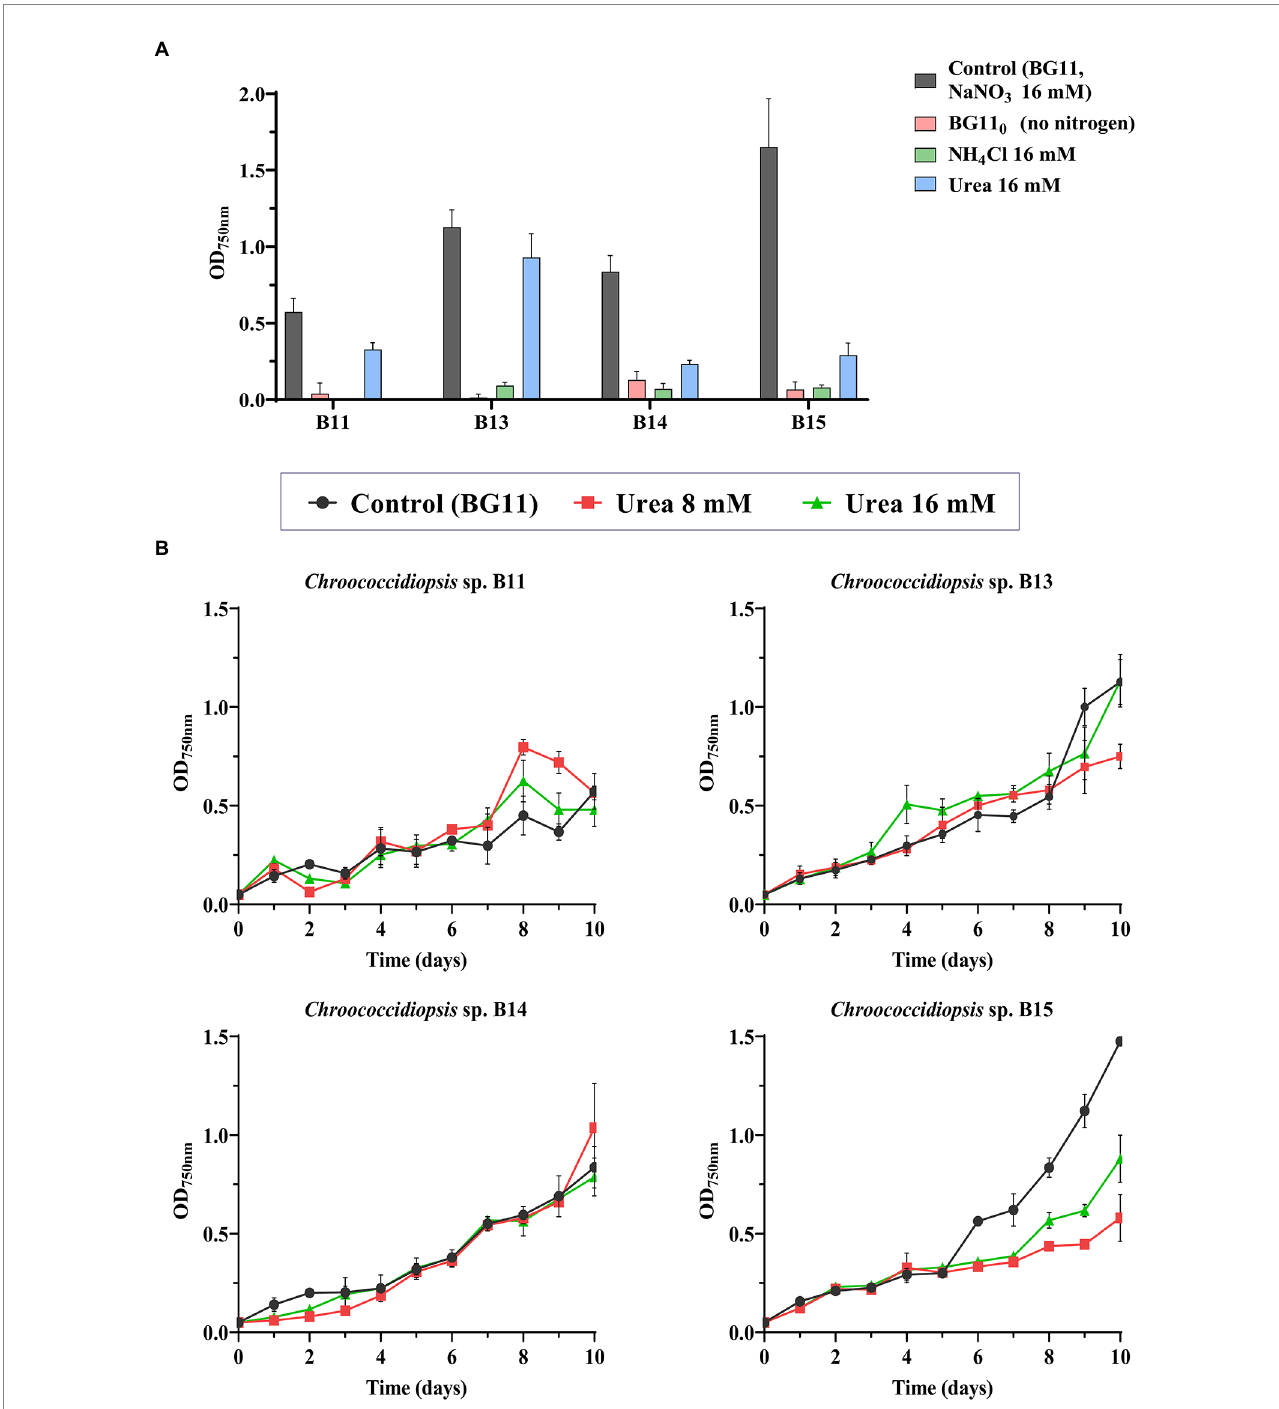
FIGURE 4 Effect of nitrogen source on the growth of Chroococcidiopsis sp. (A) OD 750nm after 10 days of growth using different nitrogen sources. As control, BG11 was used (NaNO 3 16 mM). In NH 4 Cl and urea treatments, NaNO 3 in BG11 was substituted for urea or NH 4 Cl (16 mM). Alternatively, no nitrogen was added (BG11 0 ). (B) Tolerance to urea in the different Chroococcidiopsis isolates. Urea at 8 and 16 mM was added to BG11 complete medium (containing NaNO 3 16 mM). The graphs show the average OD 750nm of three biological replicates together with the standard